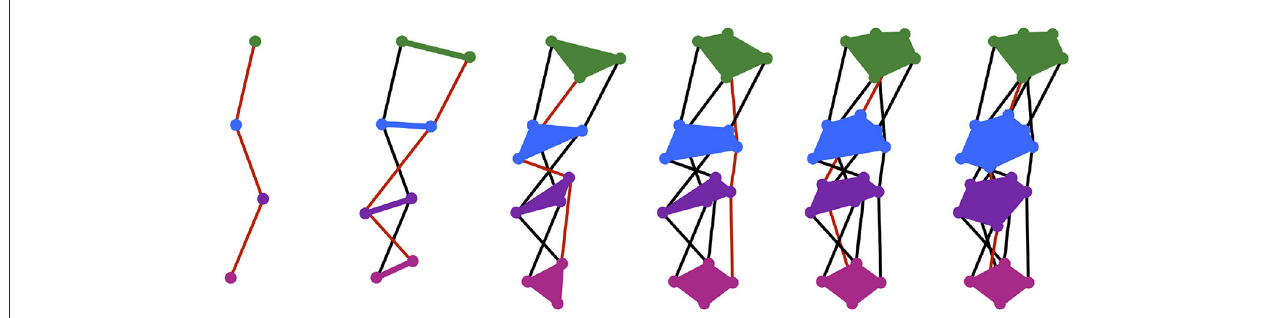
FIGURE2 Each panel shows the silhouette expanded from the previous panel to include an additional motor trajectory, whose path is shown in red. The regions of the silhouette at four time steps are drawn—the region at the first time is shown in green, at the second time in blue, at the third time in purple, and at the fourth time in pink—but theoretically infinitely many regions exist along the whole length of the silhouette. Silhouette expansion is a continual process. Motor trajectory traces are added whenever communication